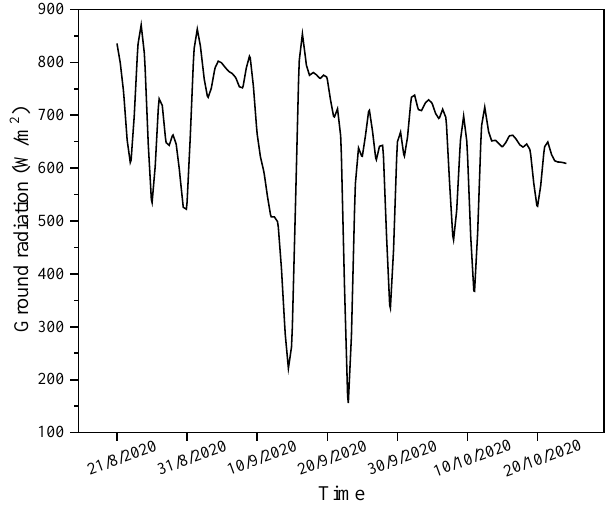
Figure 2. Changes in surface maximum radiation during the experiment.